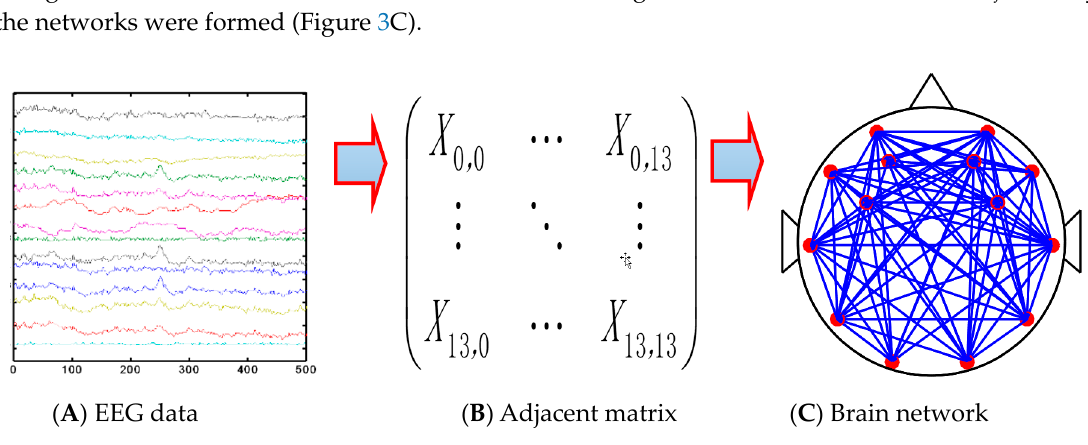
Figure 3. Steps of the construction of brain network.